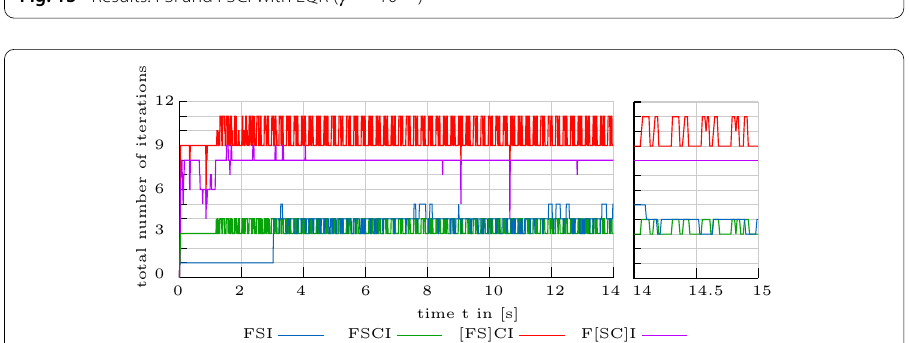
Fig. 14 Total number of iterations per time step ( γ = 10 2